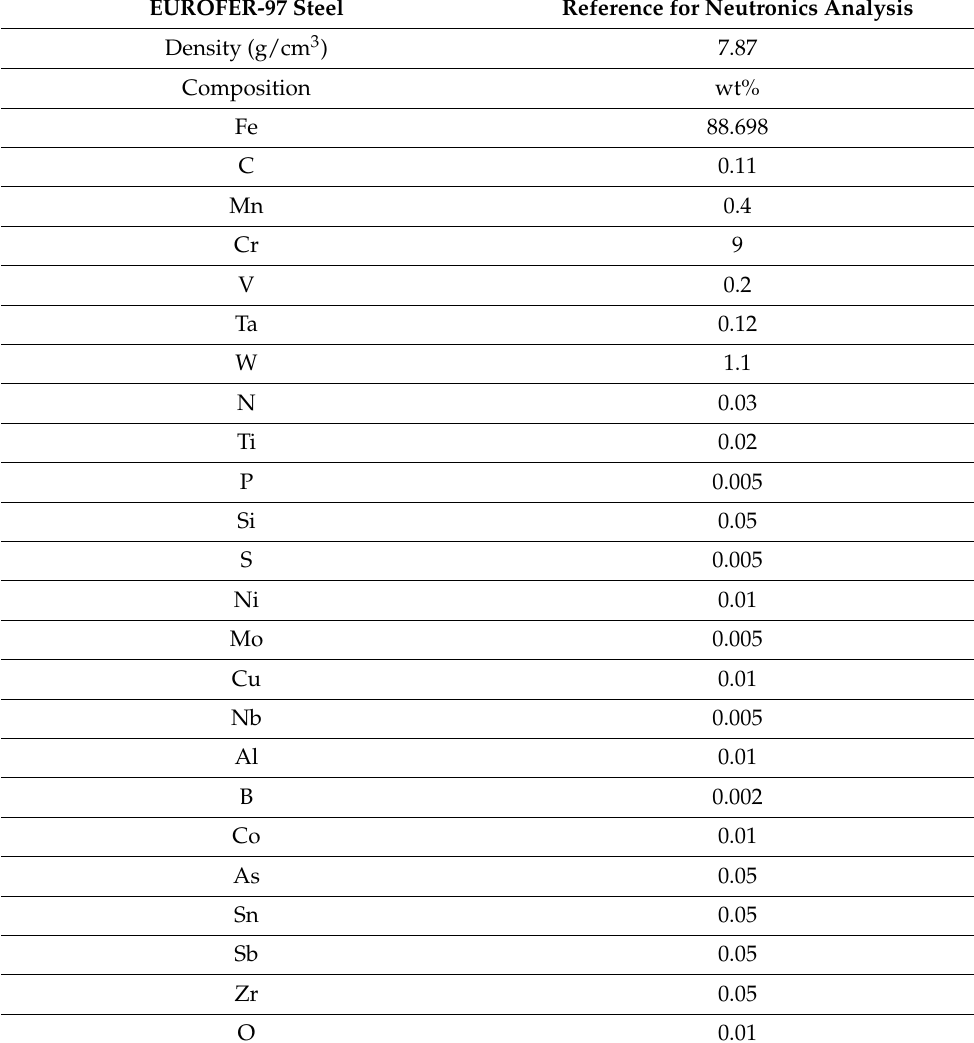
Table 4. Reference Eurofer steel composition used for neutronics analyses [47].